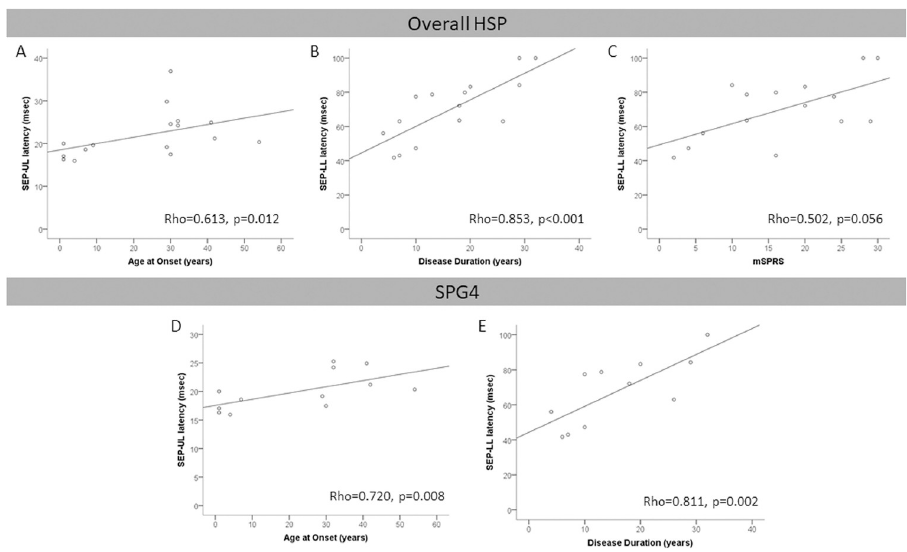
Fig 3. Correlations of somatosensory evoked potential with disease severity variables. LL: lower limbs; MEP: motor evoked potential; SSEP: Somatosensory Evoked Potential; SPRS: Spastic Paraplegia Rating Scale; msec: milliseconds; mSPRS: Motor Spastic Paraplegia Rating Scale; UL: upper